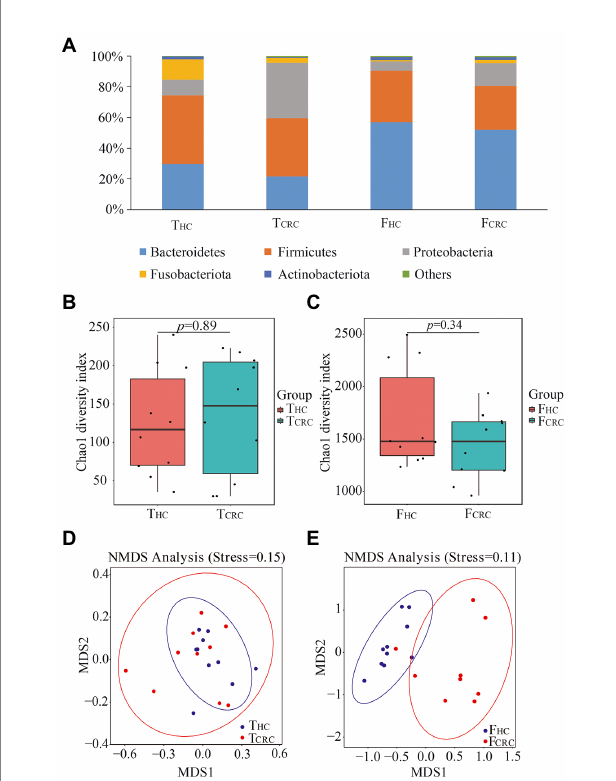
FIGURE 1 Microbial compositions at phyla level between T HC and T CRC , and between F HC and F CRC (A) groups, respectively. Chao1 indices between the T CRC and T HC (B) , and between the F CRC and F HC groups (C) , respectively. NMDS analyses between the T CRC and T HC (D) , and between the F CRC and F HC groups (E) ,